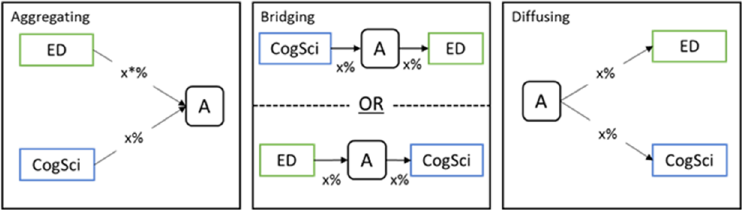
Fig 1. Definition of three types of KMEDs. Note: Aggregating-Type (A-type): More than x% of referencesof the article A are ED related sources and another more than x% of the references of the article A are CogSci related. Bridging-Type (B-type): More than x% of referencescomes from CogSci (ED) Sources whilemore than x% of the publications that cited the article A are published in ED (CogSci)-related sources. Diffusing- Type (D-type): More than x% of publicationsthat cited the article A were published in CogSci related sources and another more than x% of publicationsciting the article A were publishedin ED related